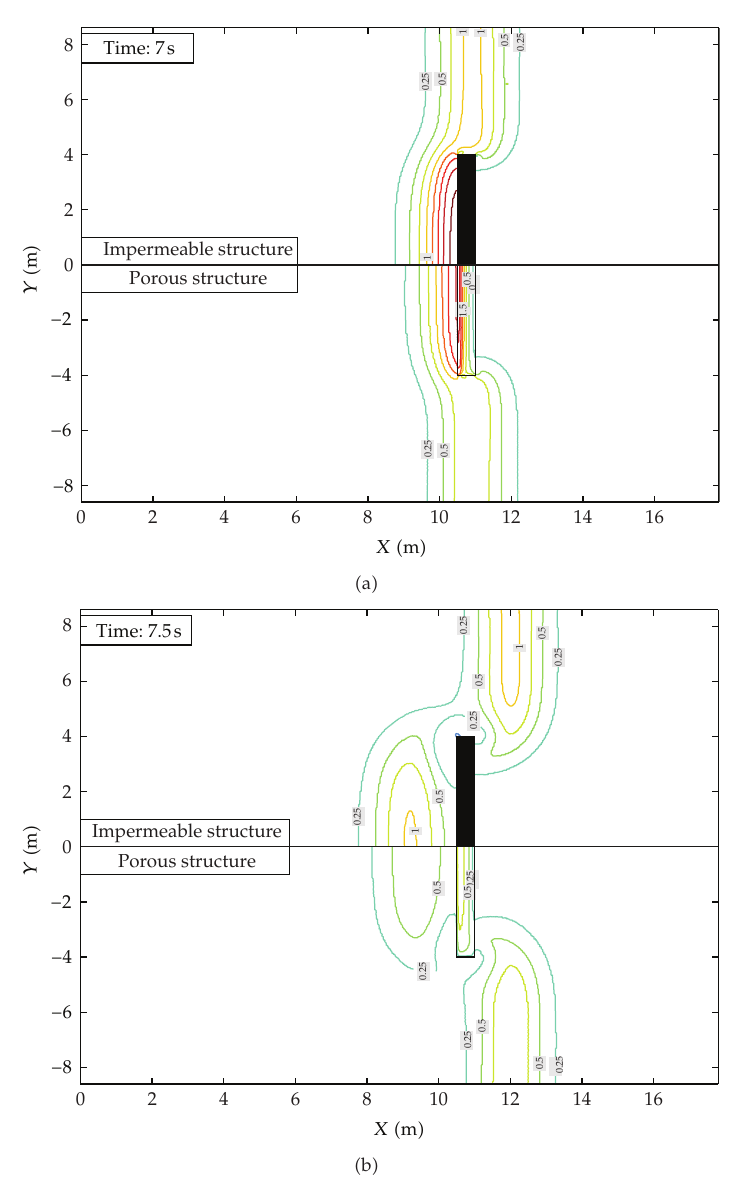
Figure 5: Free surface elevation isolines for the impermeable and porous structure under the action of the solitary wave of height H (cid:7) 9cm and water depth h (cid:7) 40cm, part